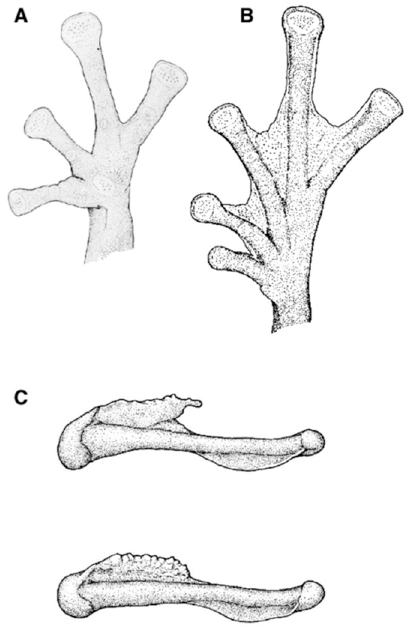
Figure 155. Nymphargus griffithisi . ( A ) Hand in ventral view, KU 118040. ( B ) Foot in ventral view, KU 118040. ( C ) Ventral humeral crests ( Top: KU 288992; Bottom: KU 188148). ( A , B ) Modified from Lynch and Duellman [22]. ( C ) Modified from Guayasamin et al. [1]. Color in ethanol: Dorsal surfaces lavender with small dark marks. Anterior half to two-thirds of parietal peritoneum white, posterior part translucent; pericardium white; most visceral peritonea clear, except for white peritoneum covering renal capsules.